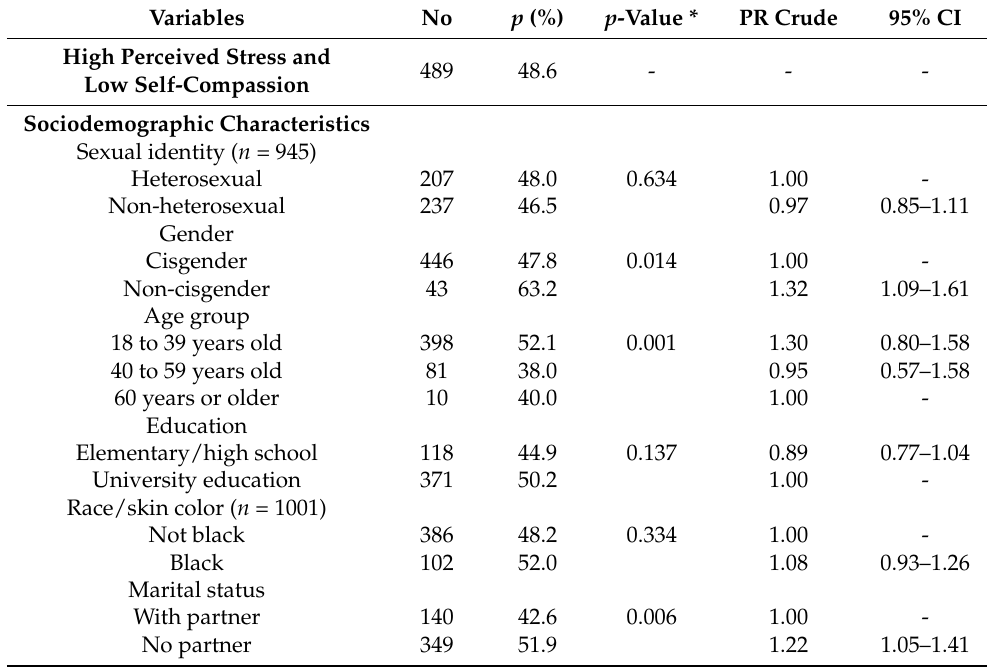
Table 2. Estimates of the combined situation of low self-compassion and high perceived stress according to sociodemographic characteristics and mental health status Brazil, 2020. ( n =